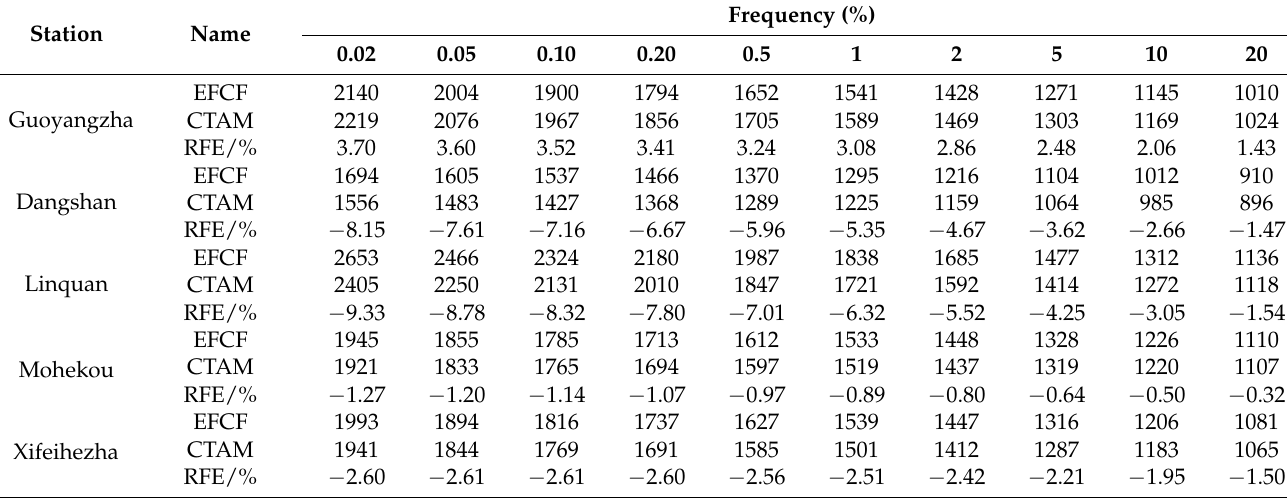
Table 4. Fitting result of annual precipitation for different returning periods in northern Anhui province, China.